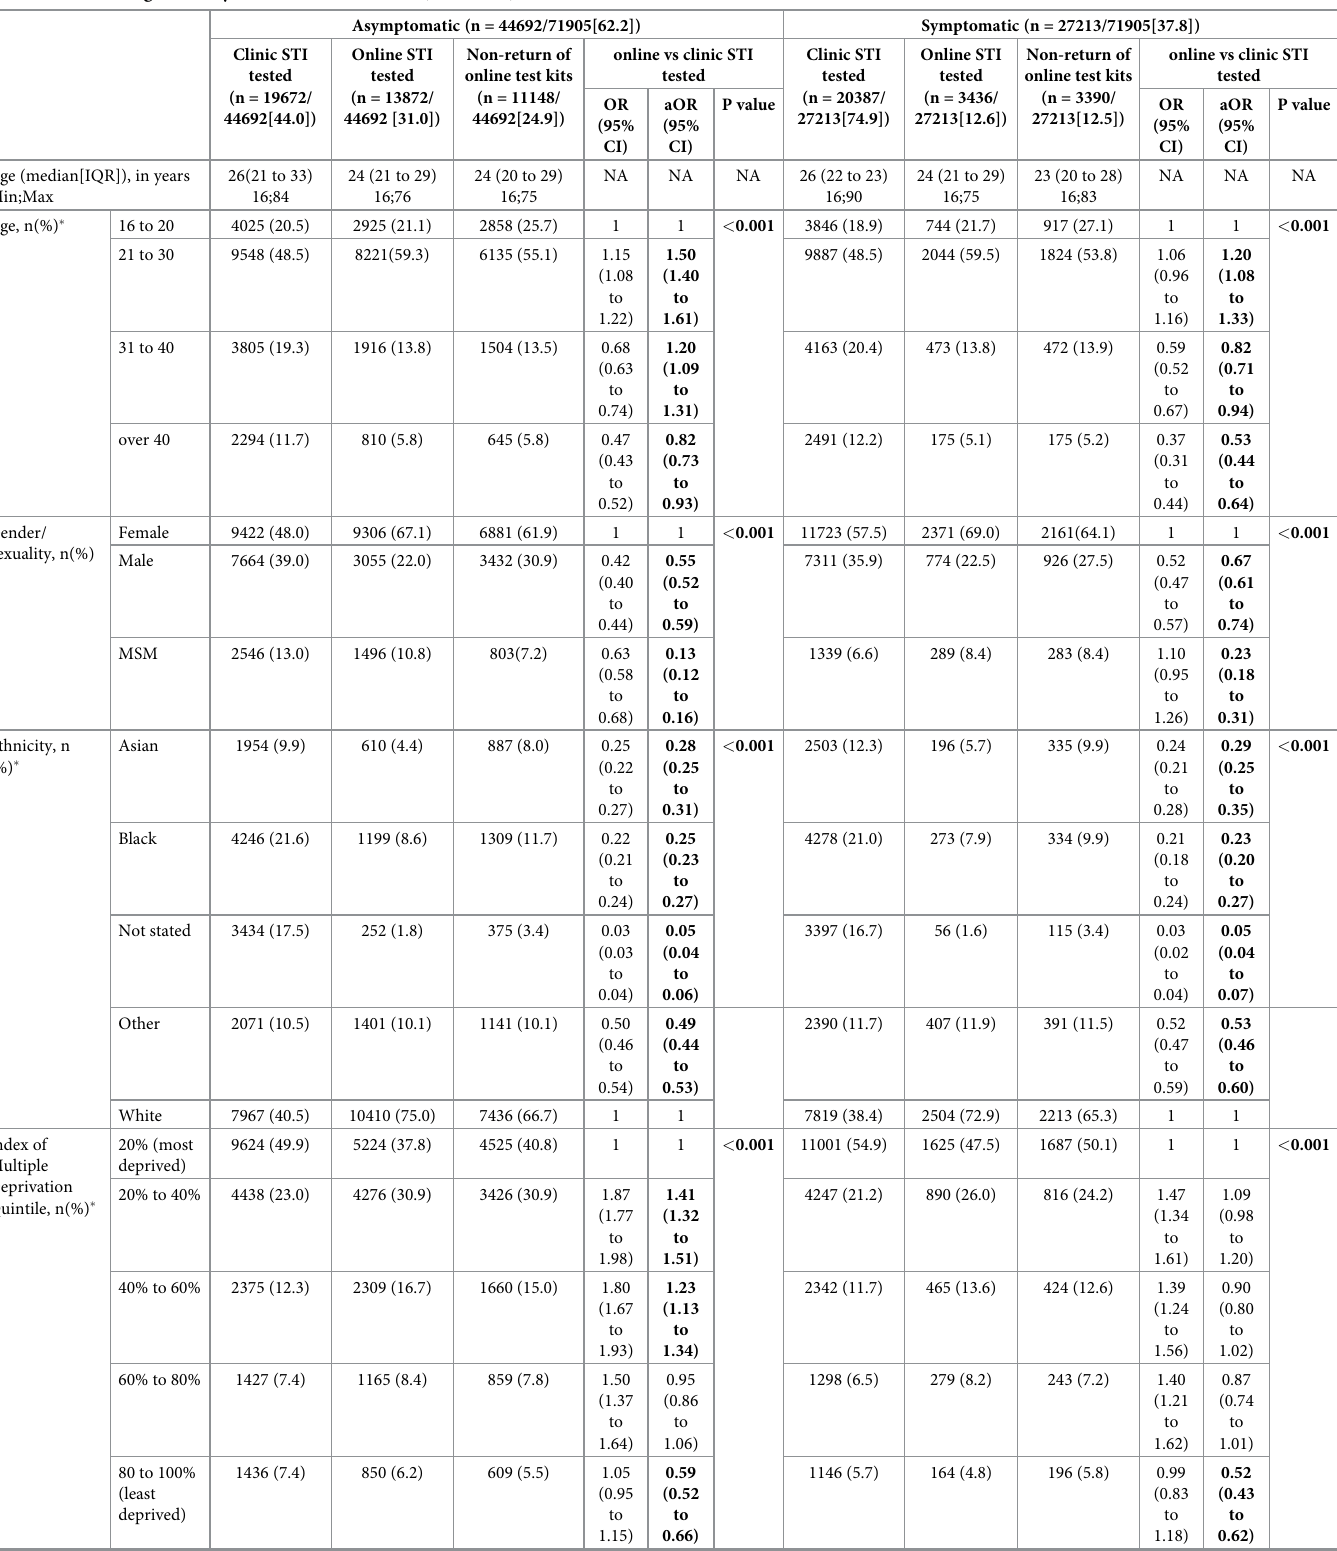
Table 1. STI testing modality and associated factors (n = 71906)